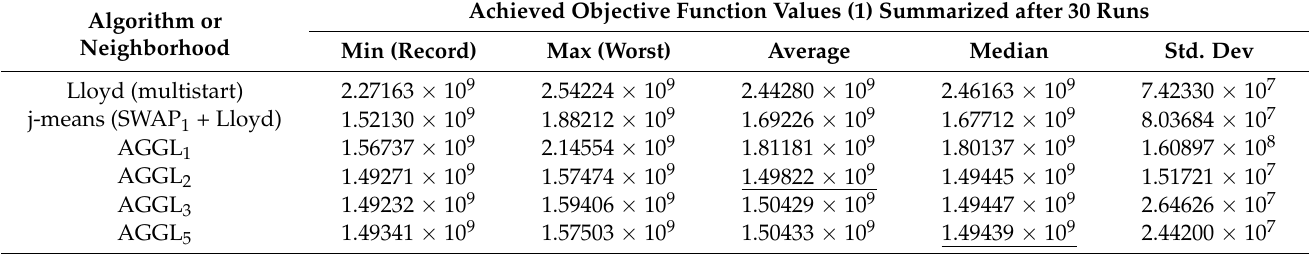
Table A2. Comparative results for BIRCH3 dataset. 10 5 data vectors in R 2 , p = 100 centers, time limitation 10 s. Algorithm